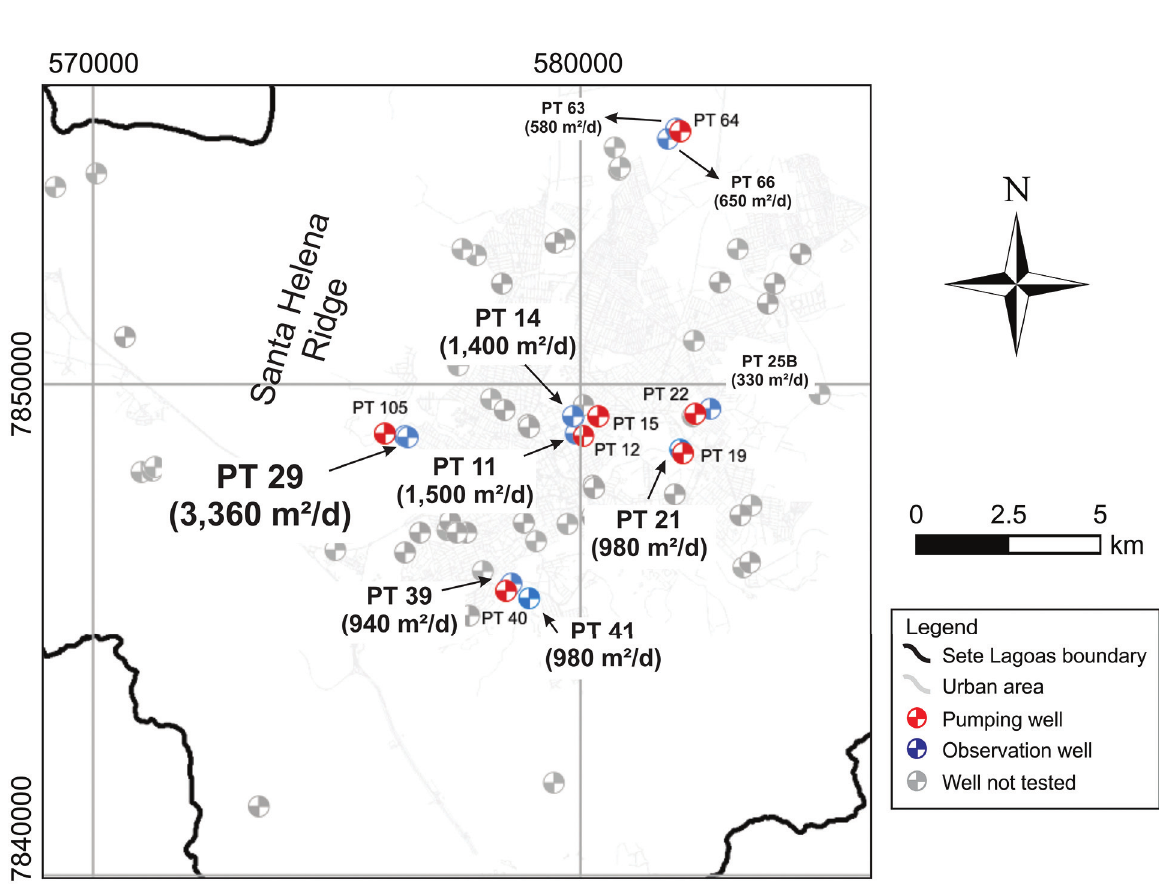
Figure 4 – Transmissivity values, T , estimated by long duration (48 h) transient pumping tests. The highest T values were noted in the central urban area of Sete Lagoas and near the Santa Helena Ridge.